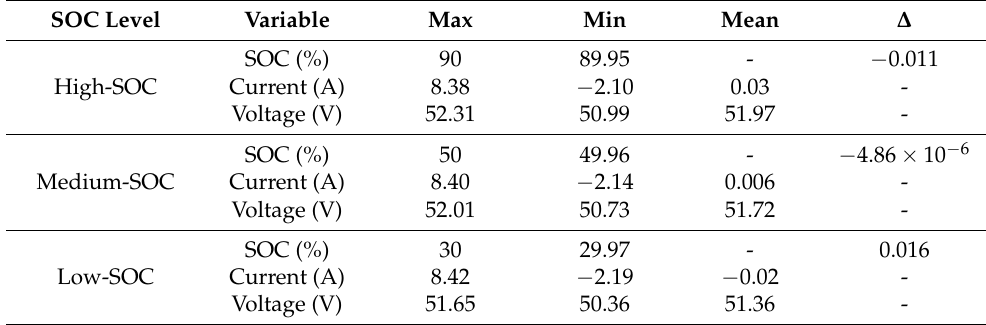
Table 3. Battery response in high, medium and low SOC passive hybrid